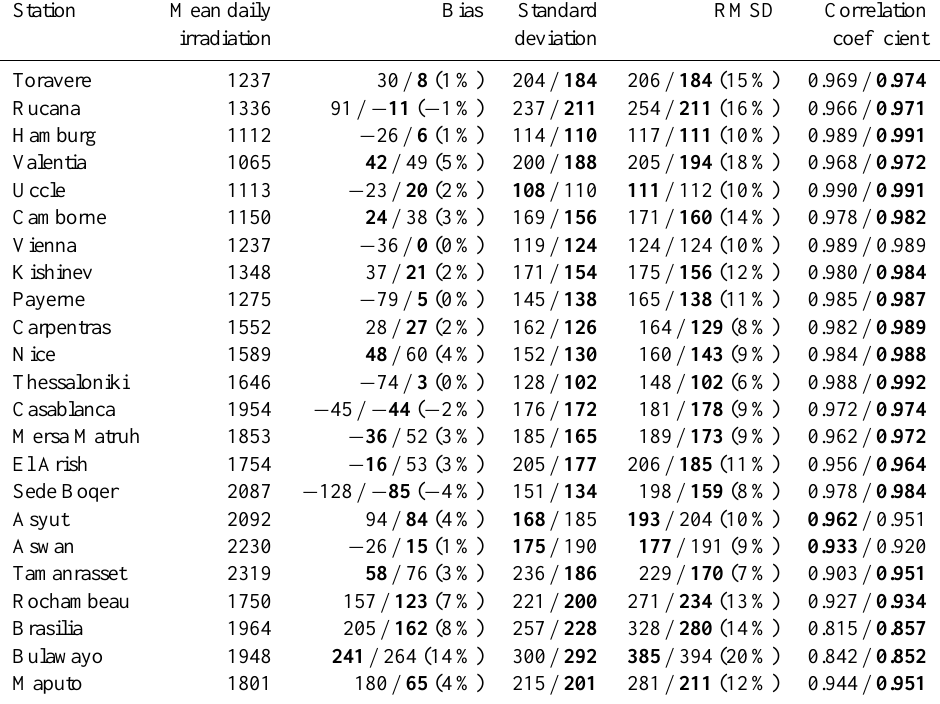
Table 5. Comparison of differences for daily irradiation, in Jcm − 2 . The mean value is obtained from the measurements. The first value is I HC3v3 and the second is I HC3McClear , with the best value in bold. Bias and RMSD of I HC3McClear relative to the mean irradiation are given in